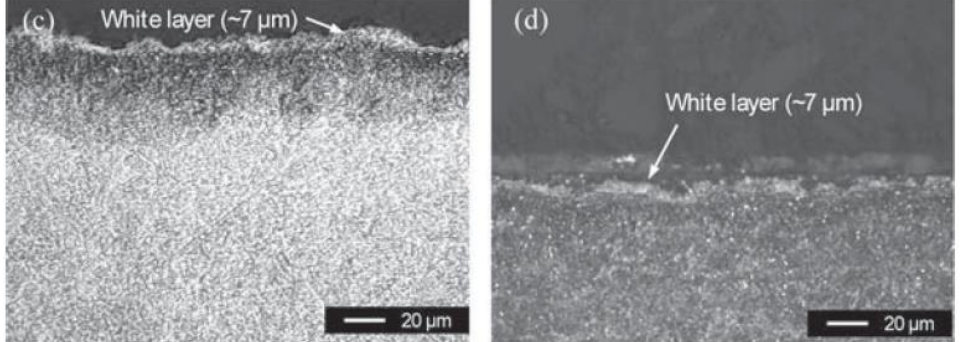
Figure 1: Surface integrity and microscopic view (Jawahir et al., 2009)